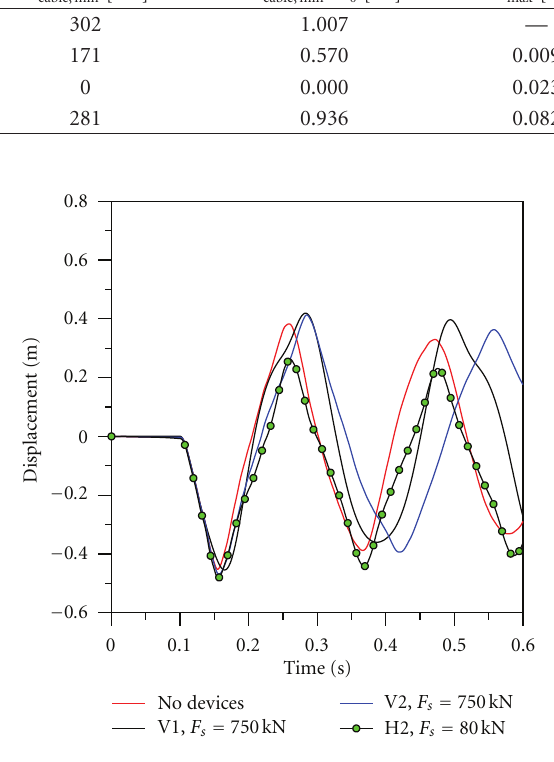
Figure 15: Comparison of mid-span cable deflection, as a function of time (ABAQUS). M02 FE-model,